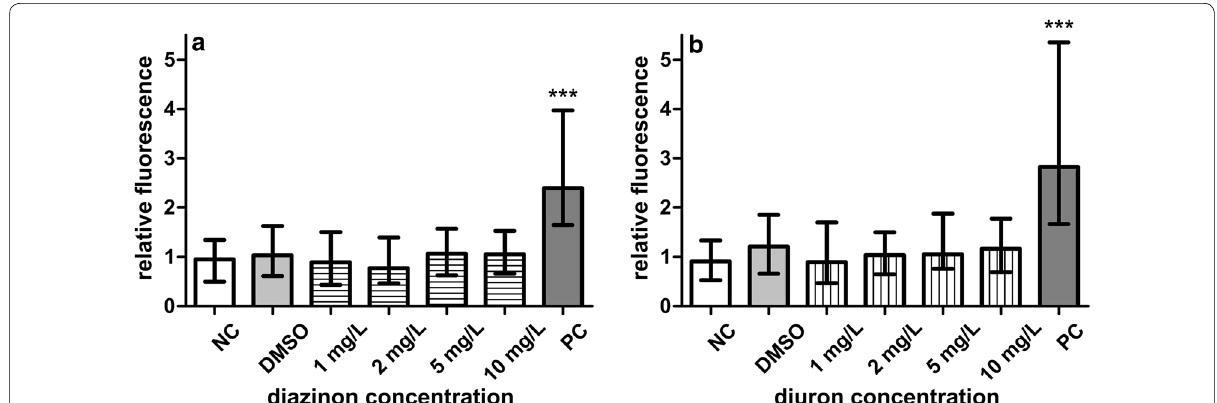
Fig. 2 Fluorescence measured in zebrafish larvae (96 hpf) exposed to diazinon ( a ) and diuron ( b ) for 2 h and incubated with CM‑H 2 DCFDA (2 h) for ROS detection. NC: negative control; DMSO: solvent control, 0.1% DMSO; PC: positive control ( tert ‑BHP). Bars represent medians with interquartile range of six repeated experiments (12 larvae per condition in each repetition). Analyses were made in comparison to the DMSO solvent control condition and significant differences are labeled with *** p < 0.001